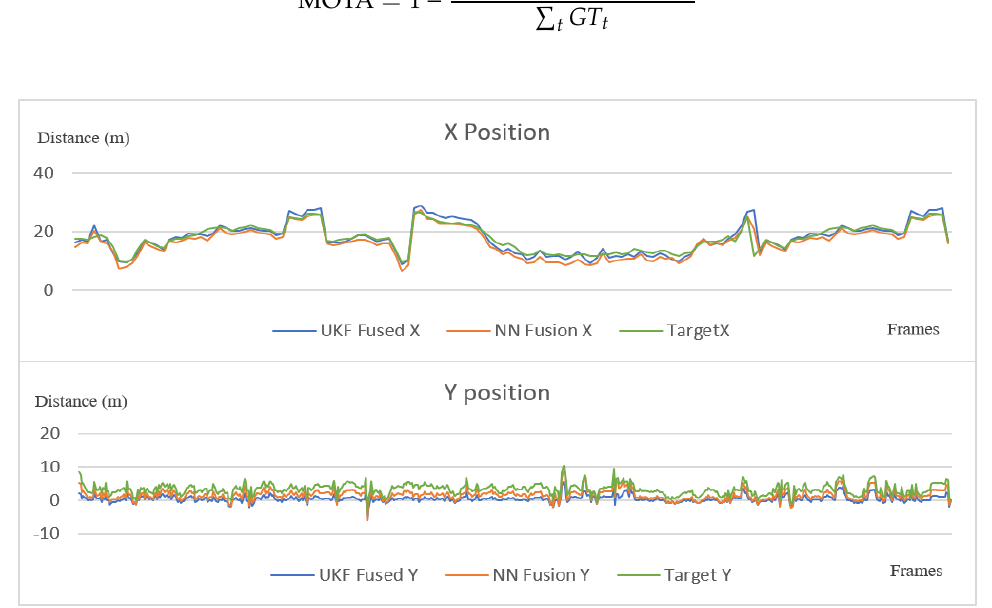
Figure 22. Position performance on the x and y axes of the proposed sensor fusion methods and the target vehicle.